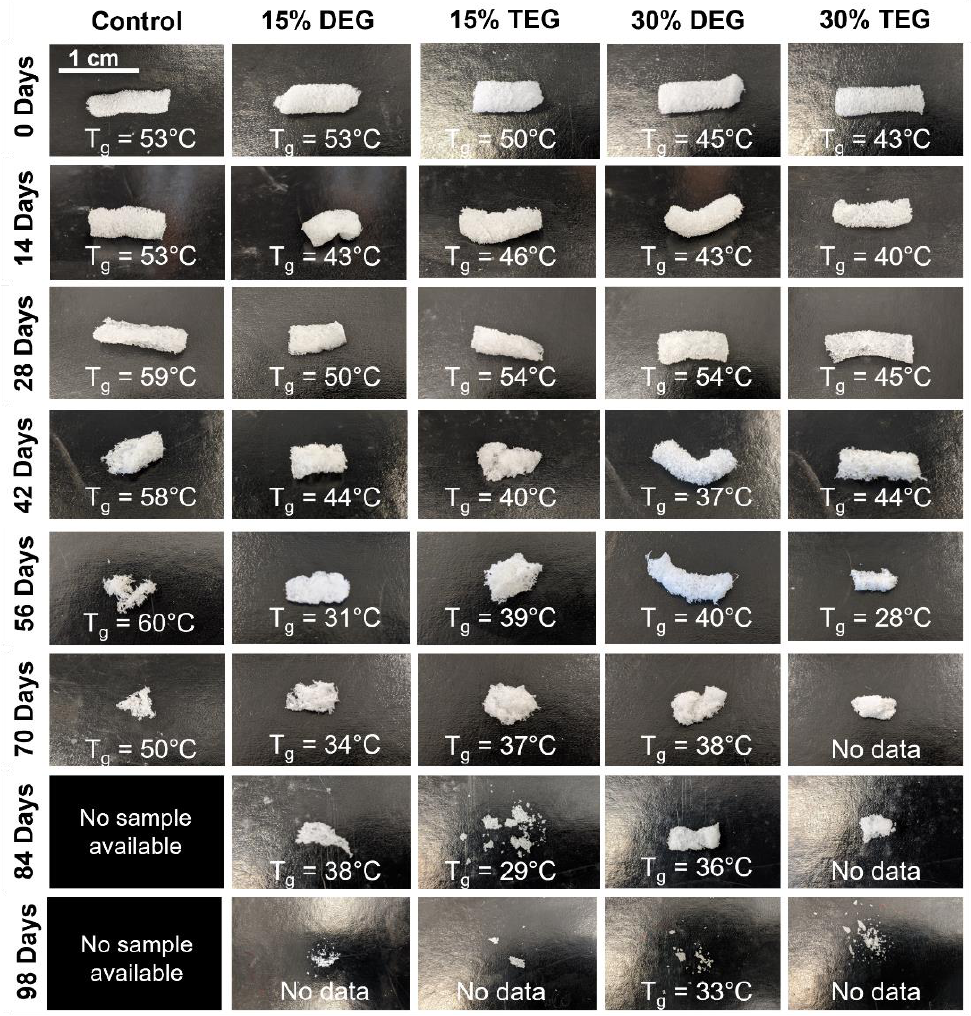
Figure 4. Physical erosion profile of samples degrading in oxidative degradation media, 3% H 2 O 2 along with respective T g ’s measured at each time point. Scale bar applies to all images.